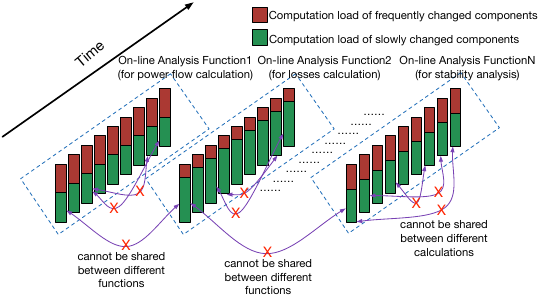
Figure 1. Computation load of the power system analysis